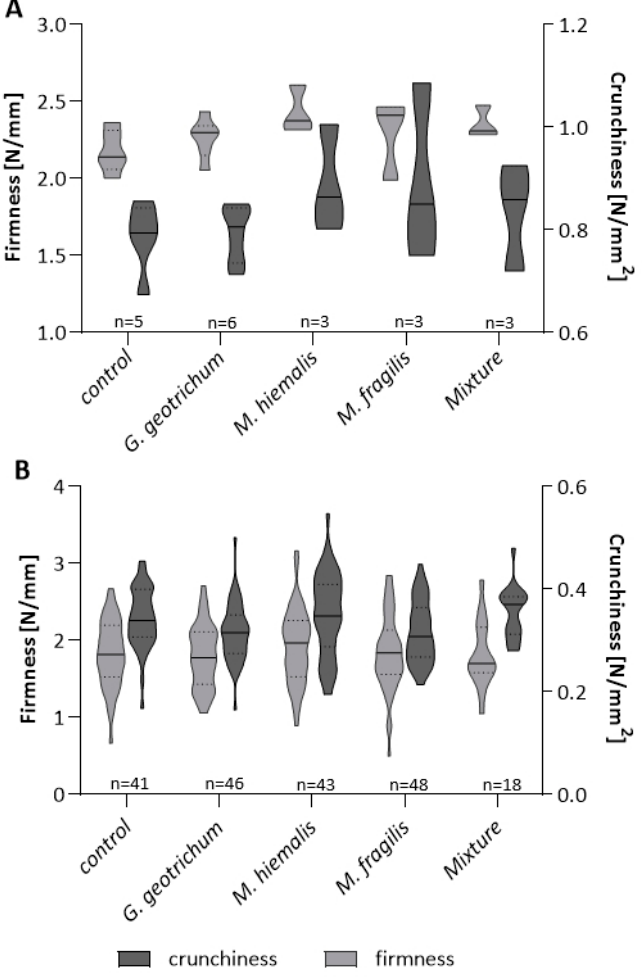
Figure 6. Texture of fresh and pasteurized inoculated greenhouse gherkins. Blossoms of gherkin plants grown in the greenhouse were sprayed with spore suspensions of Galactomyces geotrichum